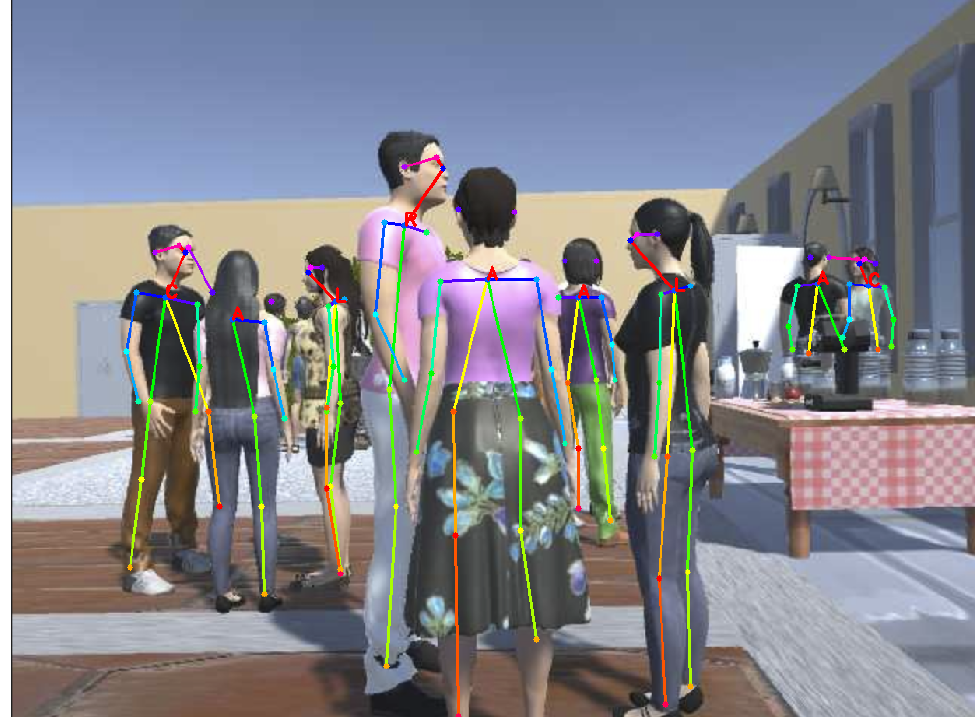
Figure 16. Our approach—V6KP, estimating head orientation of people in Scene 1 from an egocentric view. The letter A stands for facing about , R stands for facing right , C stands for facing centre , and L stands for facing left